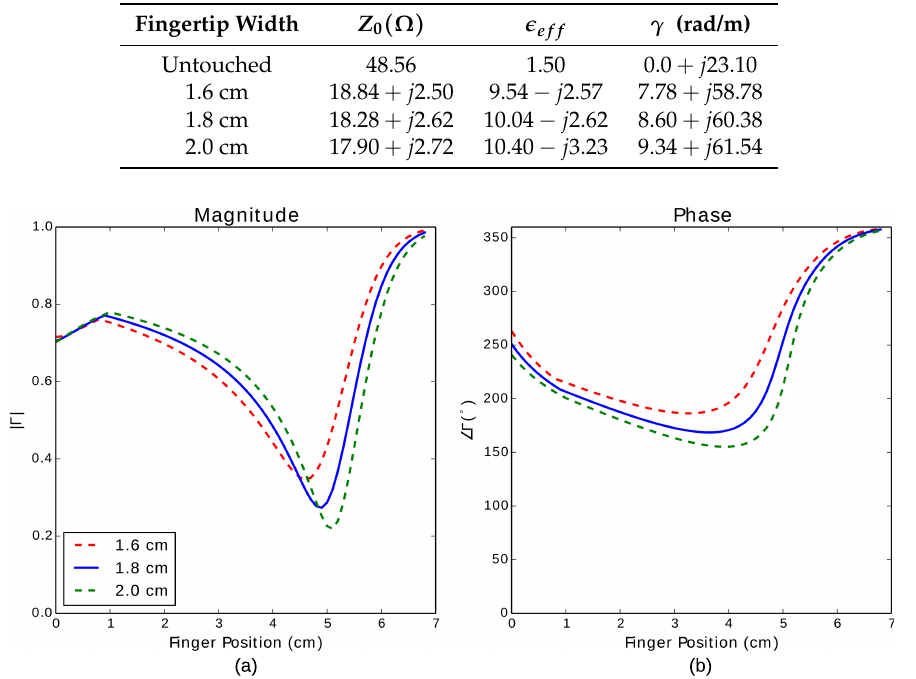
Table 1. Transmission line parameters for a touched and untouched microstrip.